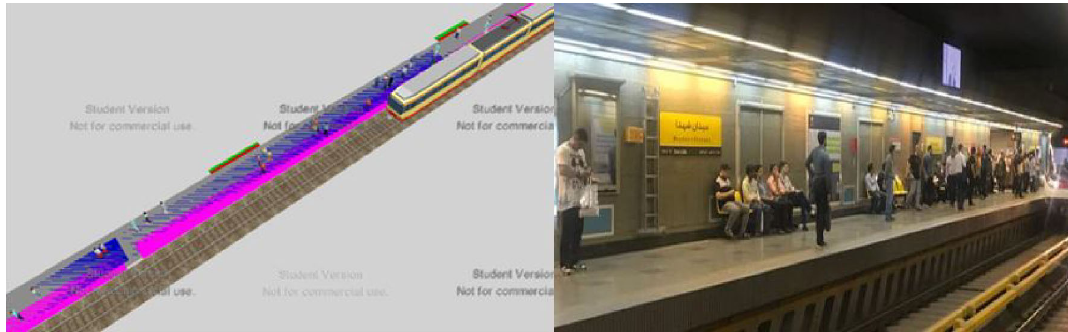
Fig. 4 Validation of platform in Shohada Square station Table 5 Deviation percent of pedestrian numbers in Shohada Square